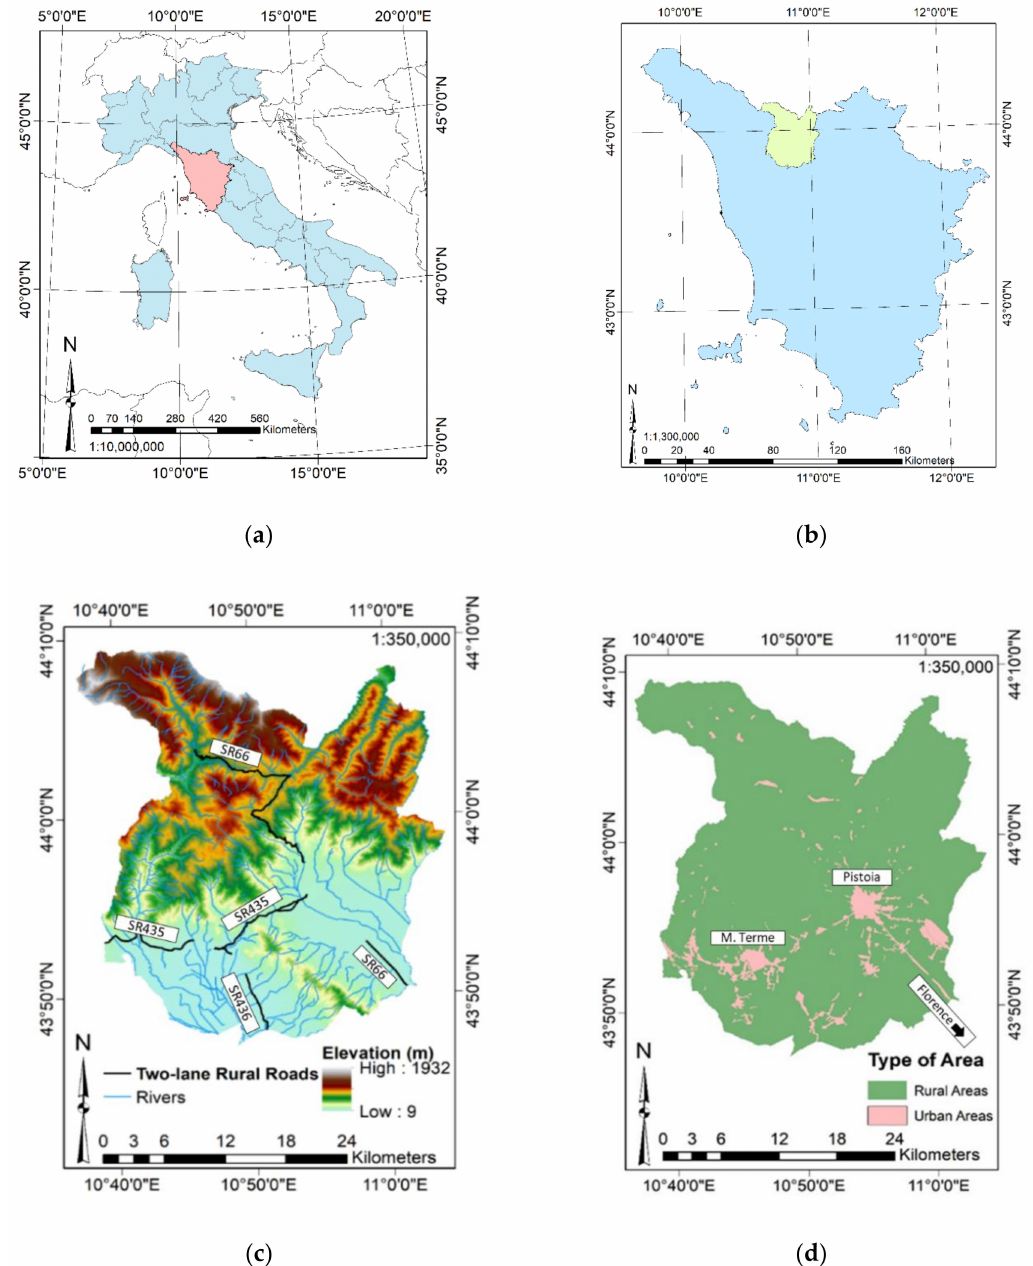
Figure 1. Study area: ( a ) Italy (light blue) and the Tuscany Region (pink). ( b ) Tuscany Region (light blue) and the Province of Pistoia (light green). ( c ) Province of Pistoia: elevation, river network, and two-lane rural roads crossing the area. ( d ) Province of Pistoia: rural and urban areas. The present figure has been adapted from Fiorentini et al.